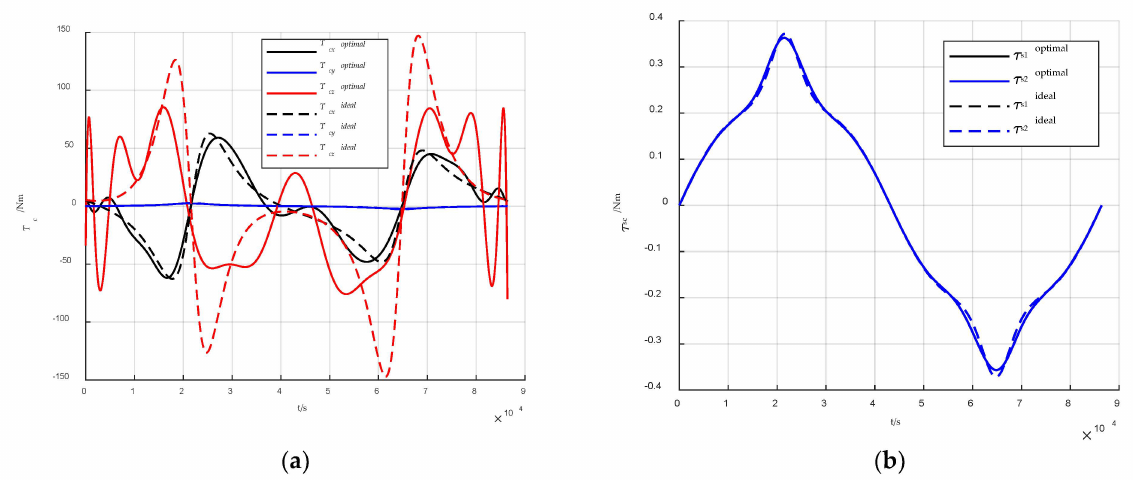
Figure 4. Control torque history around solstice. ( a ) Control torque history of the components of T c ; ( b ) Control torque history of τ scj .